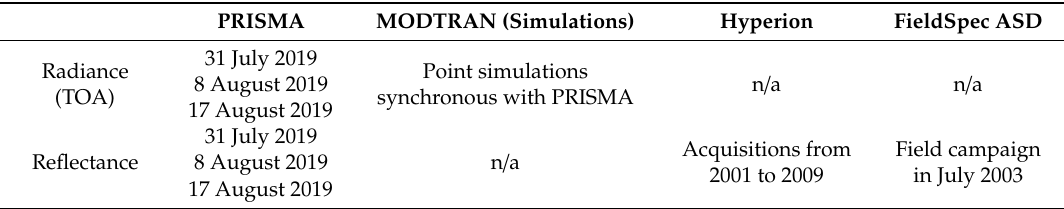
Table 1. Dataset used for comparison purposes.